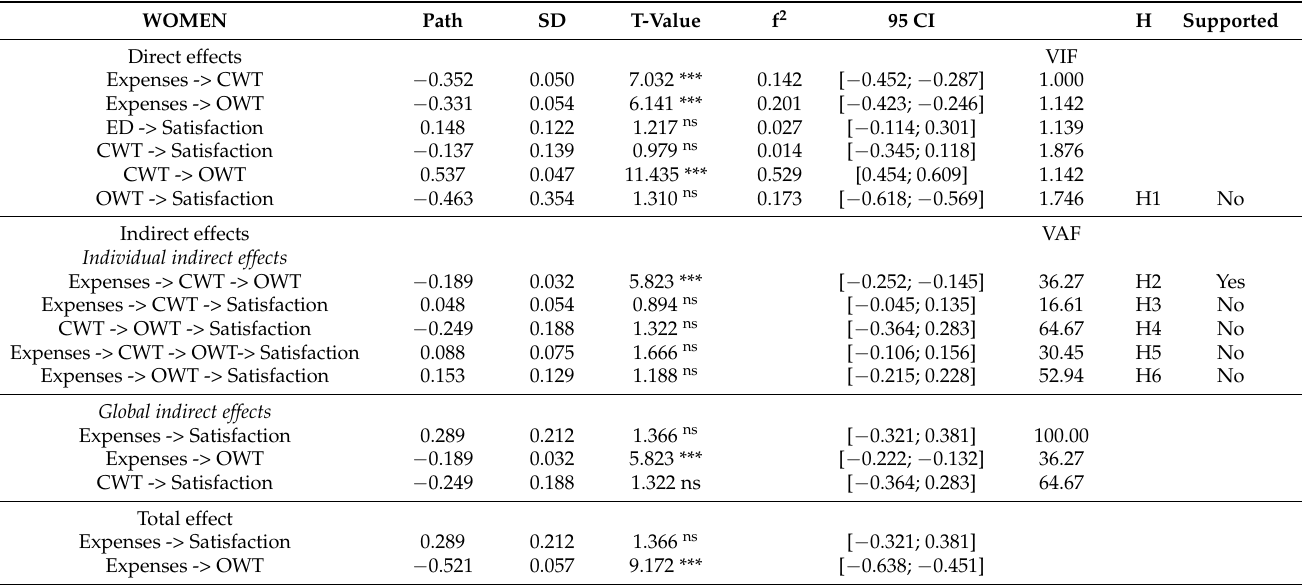
Table A2. Assessment of the structural model for